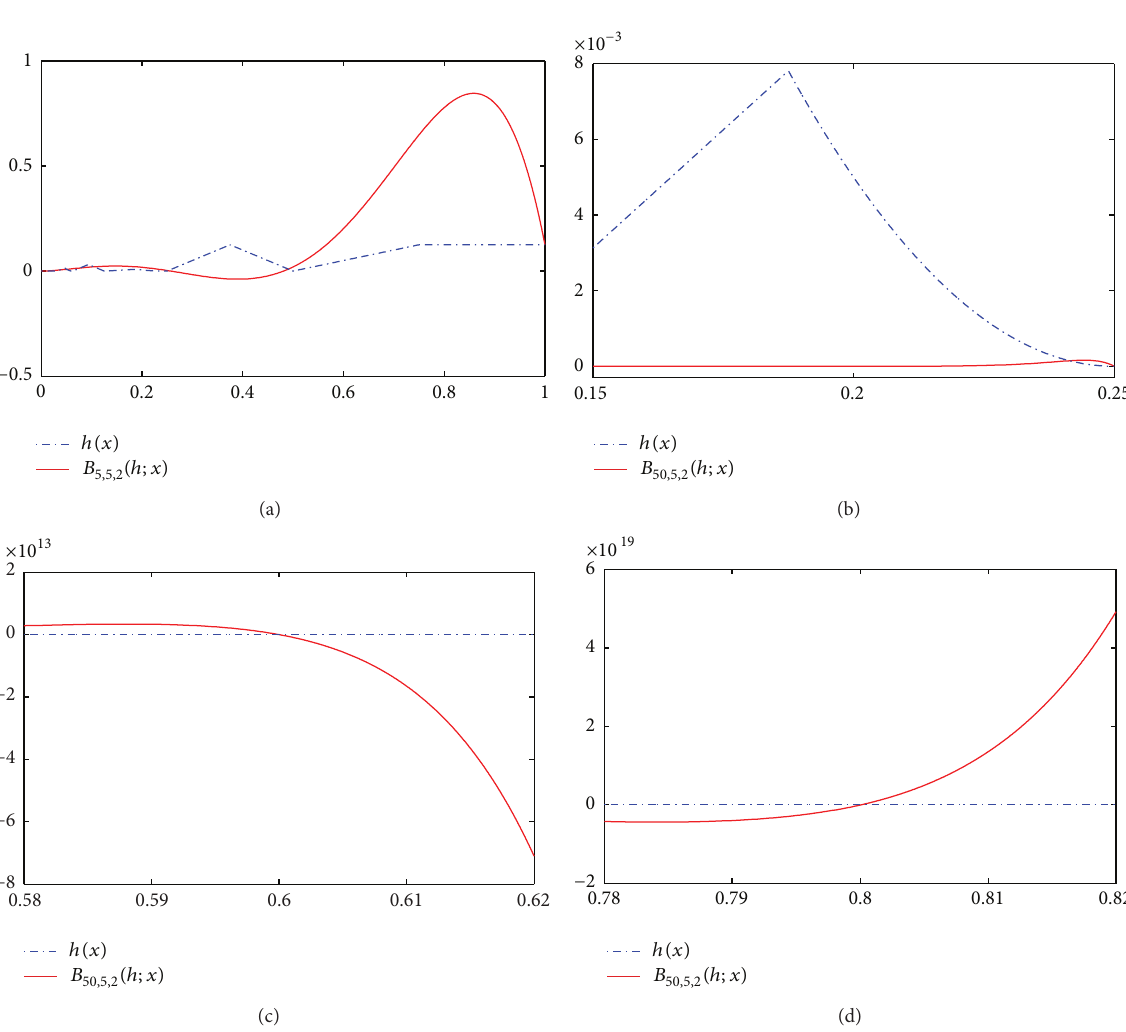
Figure 3: Graphs of ℎ and 𝐵 𝑛,5,2 (ℎ) on different intervals for some values of 𝑛